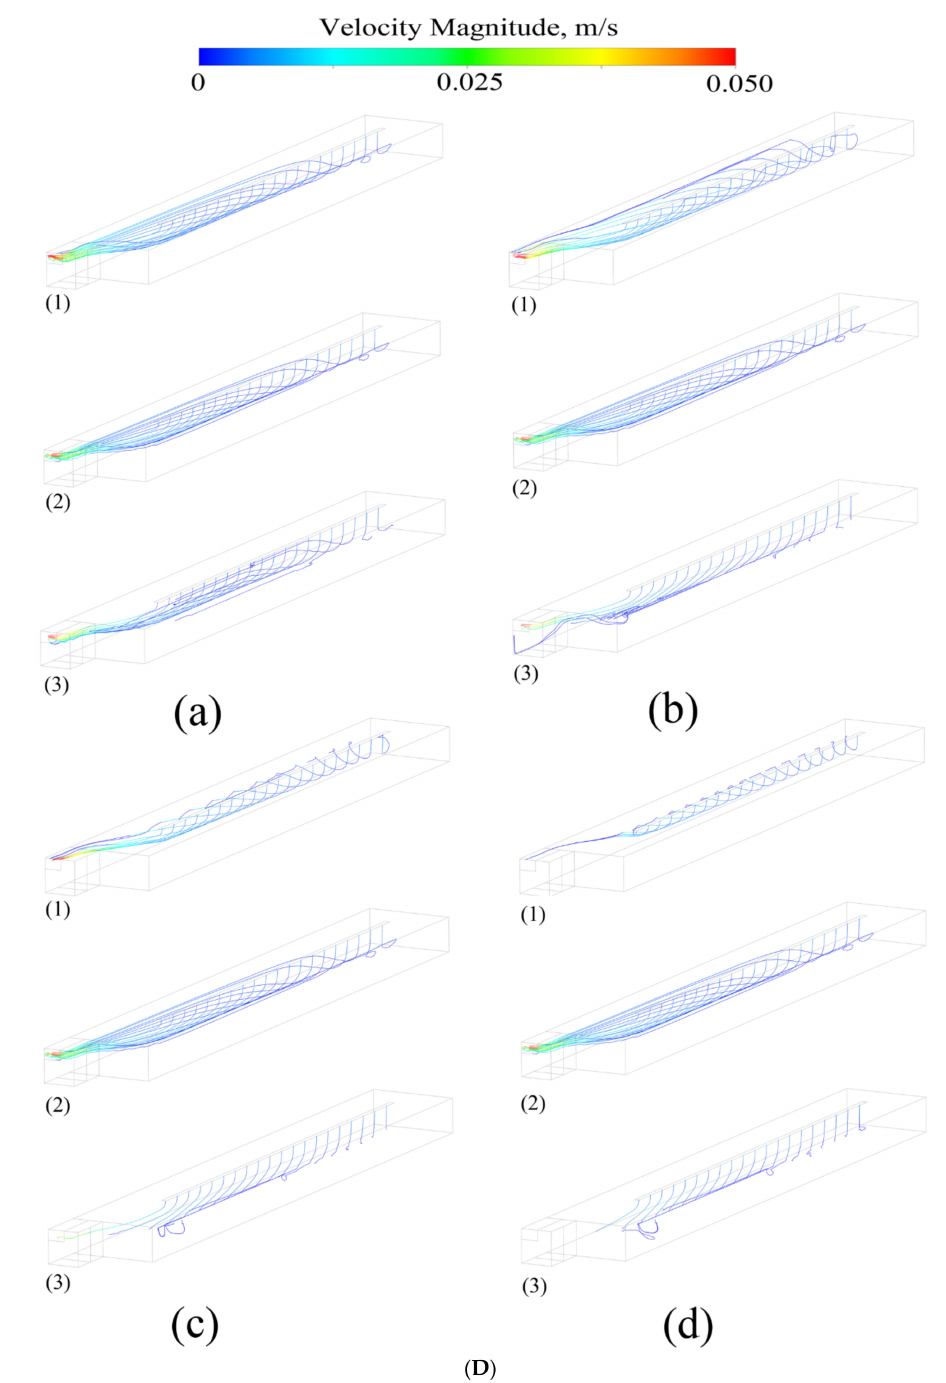
Figure 5. ( A ) The trajectory of inclusions with densities of (1) 3.5, (2) 4.5, and (3) 5.5 g/cm 3 and diameters of (a) 10, (b) 40, (c) 70, and (d) 100 µ m at a casting velocity of 2 × 10 − 4 m/s with a pour- ing temperature of 2273 K. ( B ) The trajectory of inclusions with densities of (1) 3.5, (2) 4.5, and (3) 5.5 g/cm 3 and diameters of (a) 10, (b) 40, (c) 70, and (d) 100 µ m at a casting velocity of 2.5 × 10 − 4 m/s with a pouring temperature of 2273 K. ( C ) The trajectory of inclusions with densities of (1) 3.5, (2) 4.5, and (3) 5.5 g/cm 3 and diameters of (a) 10, (b) 40, (c) 70, and (d) 100 µ m at a casting velocity of 3 × 10 − 4 m/s with a pouring temperature of 2273 K. ( D ) The trajectory of inclusions with densities of (1) 3.5, (2) 4.5, and (3) 5.5 g/cm 3 and diameters of (a) 10, (b) 40, (c) 70, and (d) 100 µ m at a casting velocity of 3.5 × 10 − 4 m/s with a pouring temperature of 2273